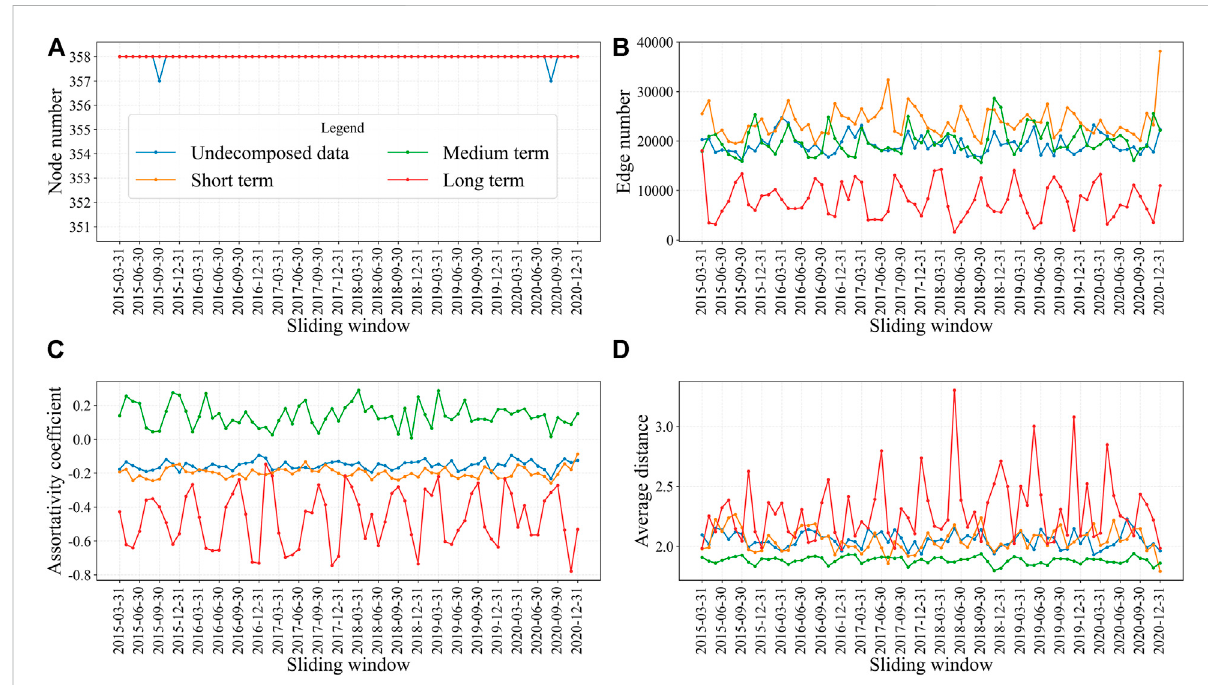
The overall properties of SNAPs on multiple timescales. Panels (A – D) represent the evolution of the node number, the edge number, the assortativity coef fi cient, and the average distance, respectively. In each panel, the X-axis represents the sliding window, and the Y-axis represents each indicator ’ s value. The four timescales, i.e., the undecomposed data, short-term, medium-term, and long-term, correspond to blue, yellow, green, and red lines,